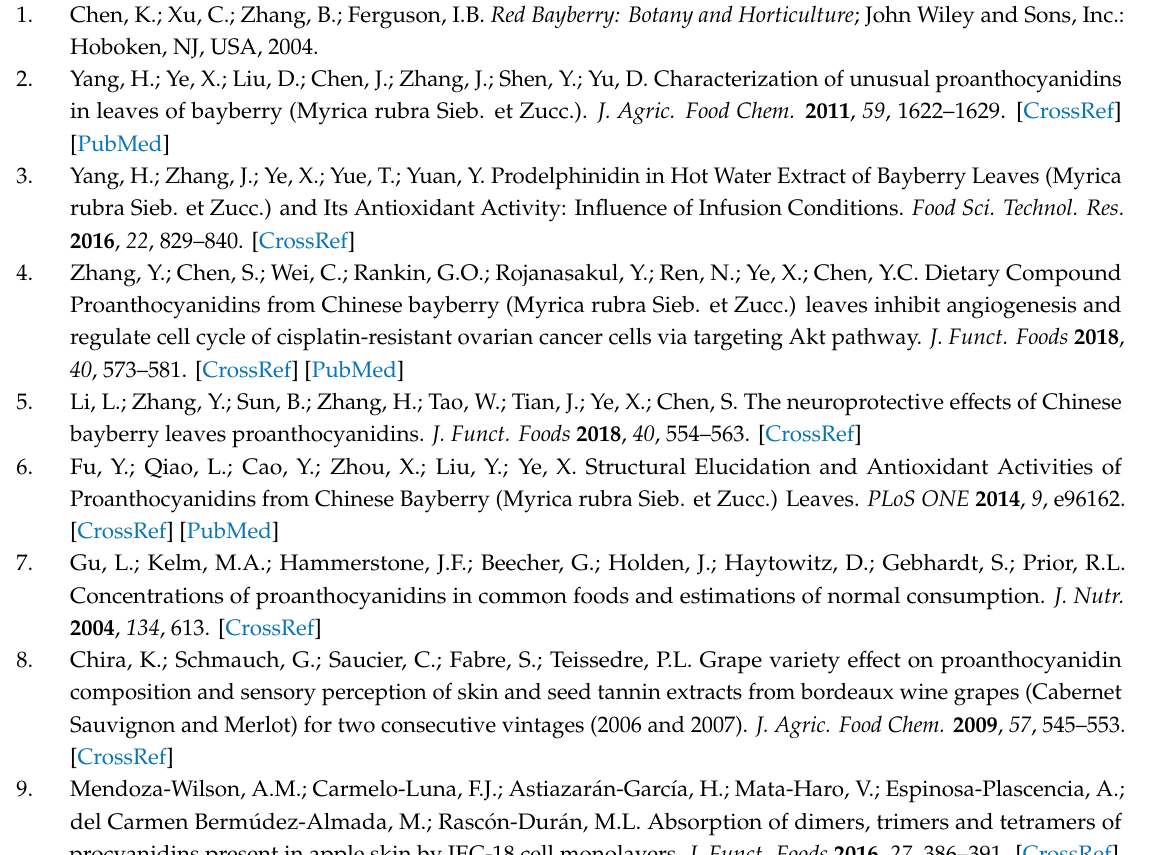
Figure S1: Reverse phase HPLC chromatograms (detected at 280 nm) of reaction products of (a) CBLPs, (b) SPBLPs and (c) UDBLPs with the presence of excess phloroglucinol. Peak 1: ascorbic acid; peak 2: phloroglucinol; peak 3: EGCG-ph; peak 4: EGCG. Table S1: Mean degree of polymerization (mDP), content of proanthocyanidins (PAs) and total phenolic content (TPC) of di ff erent varieties of Chinese bayberry leaves proanthocyanidins (BLPs), Table S2: Fractions from BLPs and their identification from normal-phase preparativie HPLC-ESI / MS and reverse-phase HPLC-ESI /